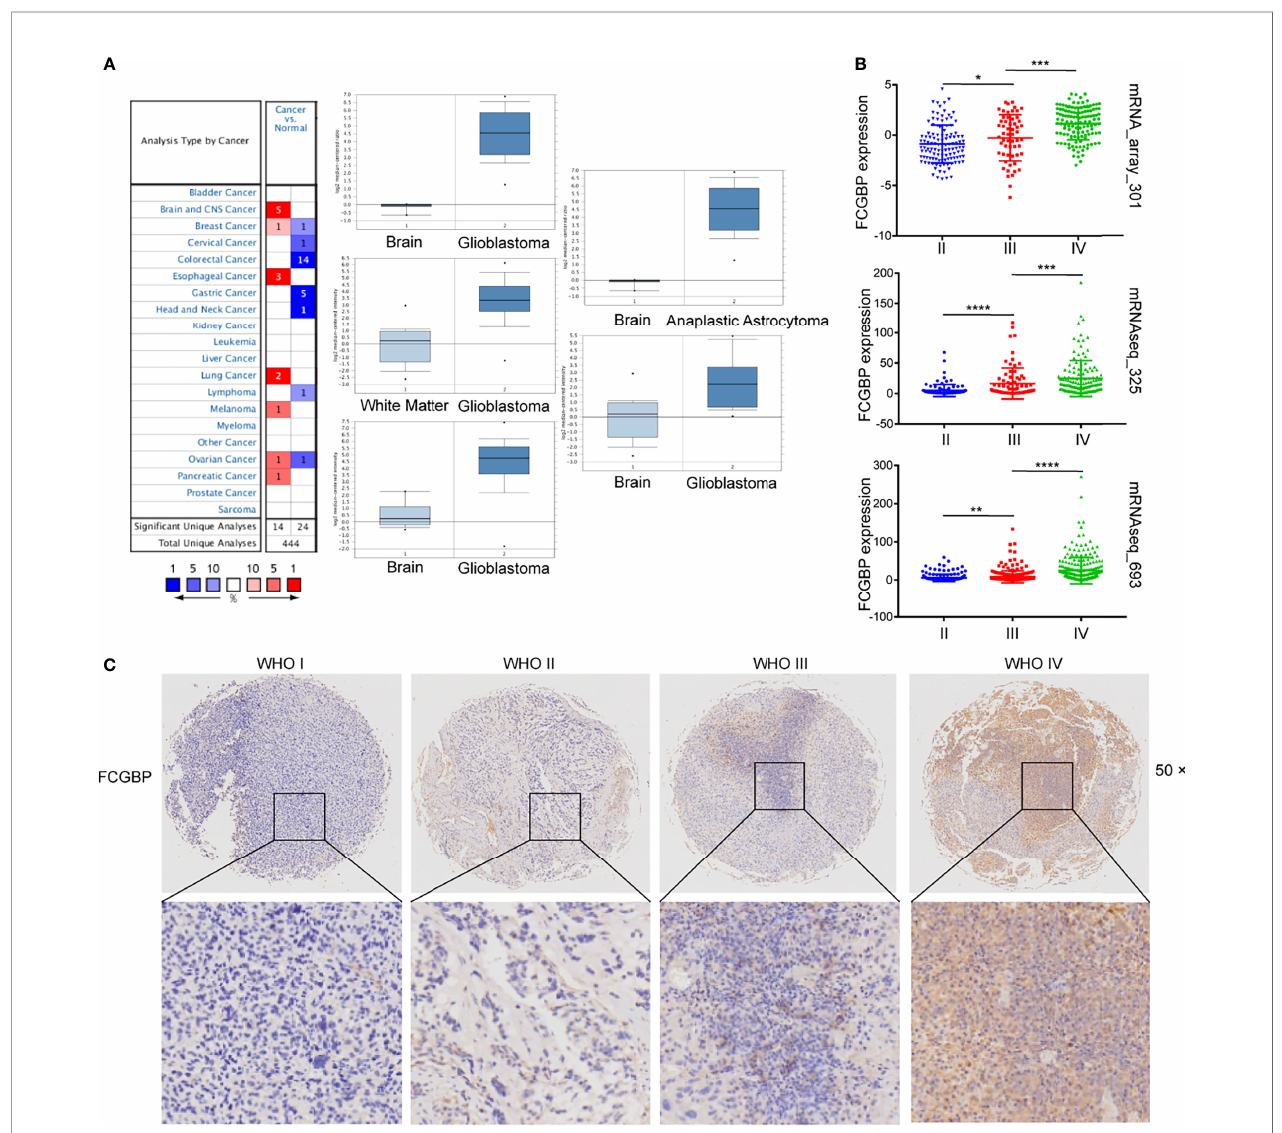
FIGURE 2 | FCGBP is up-regulated in glioma. (A) The mRNA expression level of FCGBP in different tumor tissues and normal tissues analyzed by Oncomine (* P <.05, ** P <.01, *** P <.001, **** P <0.0001). (B) The mRNA expression level of FCGBP was determined in glioma tissues by CGGA database (* P <.05, ** P <.01, *** P <.001). (C) Typical images of IHC staining of FCGBP in glioma